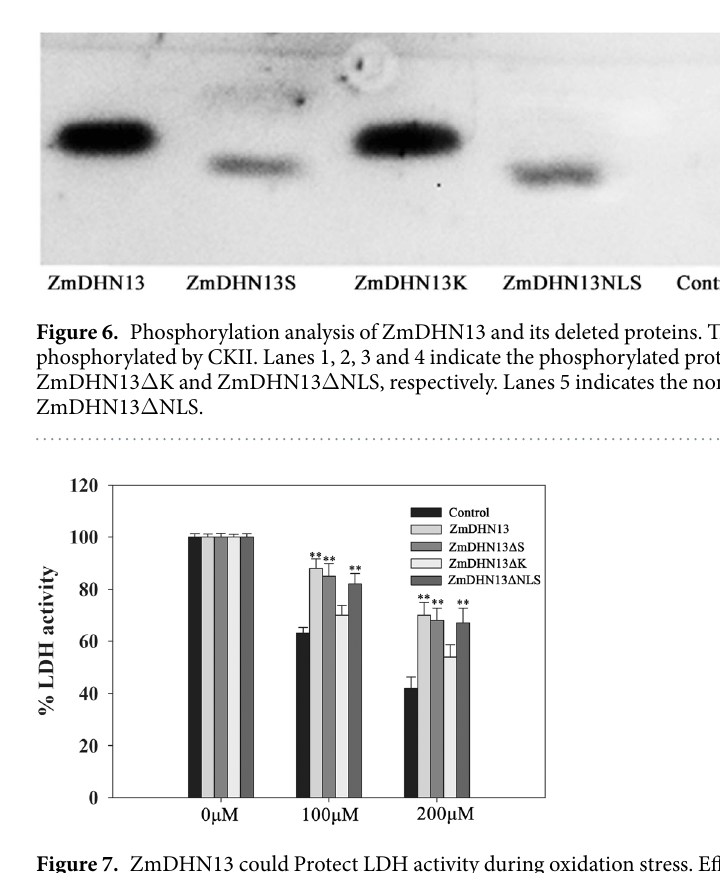
Figure 7. ZmDHN13 could Protect LDH activity during oxidation stress. Effects of oxidation on LDH activity after 100 μ M or 200 μ M H 2 O 2 treatment. LDH activity was measured in the presence of 0.24 mg of ZmDHN13 protein or 0.24 mg of BSA protein